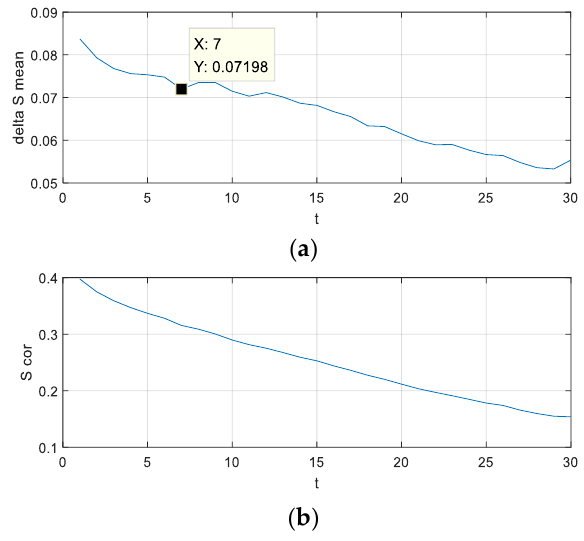
S t . ( a ) Curve of statistic   S t  ; ( b ) Curve of Figure 4. Curves of  S t  and  Figure 4. Curves of ∆ S ( t ) and S cor ( t ) . ( a ) Curve of statistic ∆ S ( t ) ; ( b ) Curve of statistic S cor ( t ) c o r S t . statistic  c o r